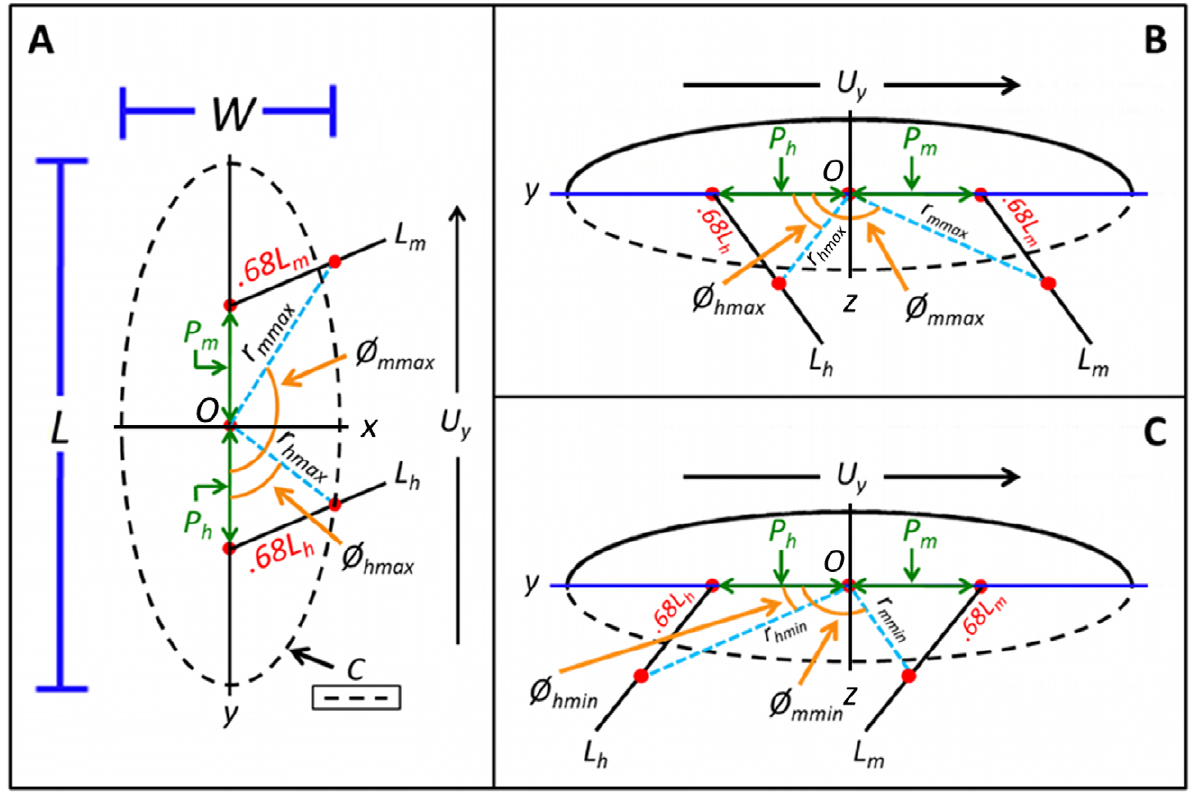
Figure 2. Diagram demonstrating how each parameter was calculated. (A) Top-down view of the body showing key parameters for swimming. (B&C) Side view of the body on the surface of water (indicated by blue line) showing both the maximum and minimum position of the legs during a leg beat when diving. In all of the above diagrams, the hind legs are indicated by the subscript h , while the middle legs are indicated by the subscript m . Using this notation, the length of the hind legs is L h , etc. The direction of motion of the beetle is indicated by an arrow showing the forward velocity ( U y ). The dashed line in B&C indicates the submerged portion of the beetle. All other parameters designations are listed in Tables 1–3